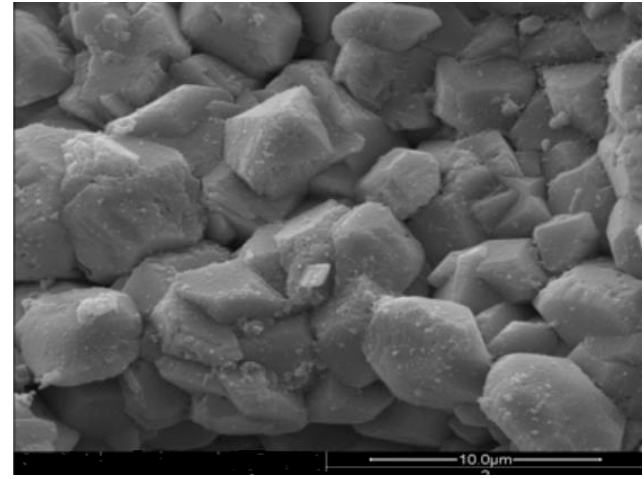
Figure 8. Scanning electron micrograph of modified ceramic after 2160-h use.